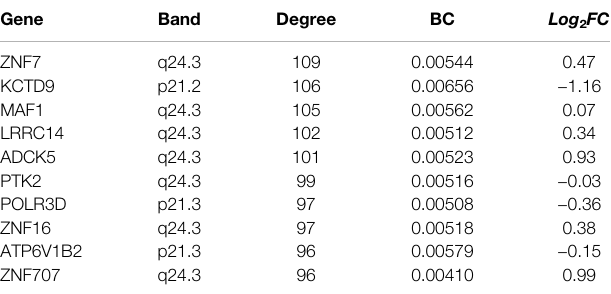
TABLE 1 | The most connected genes belong to q24.3 and